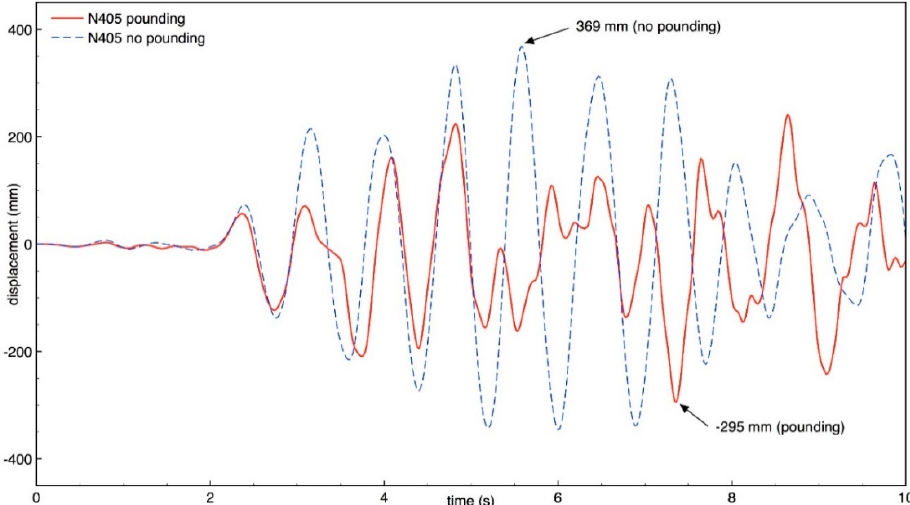
Figure 14. Longitudinal response of building B (node N401) with and without pounding.